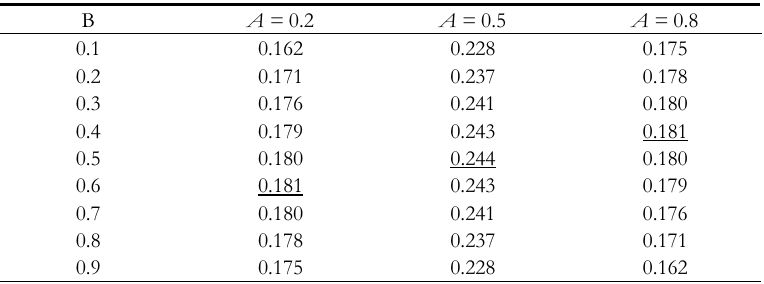
Entropies H ( X|Z ) for variable A and